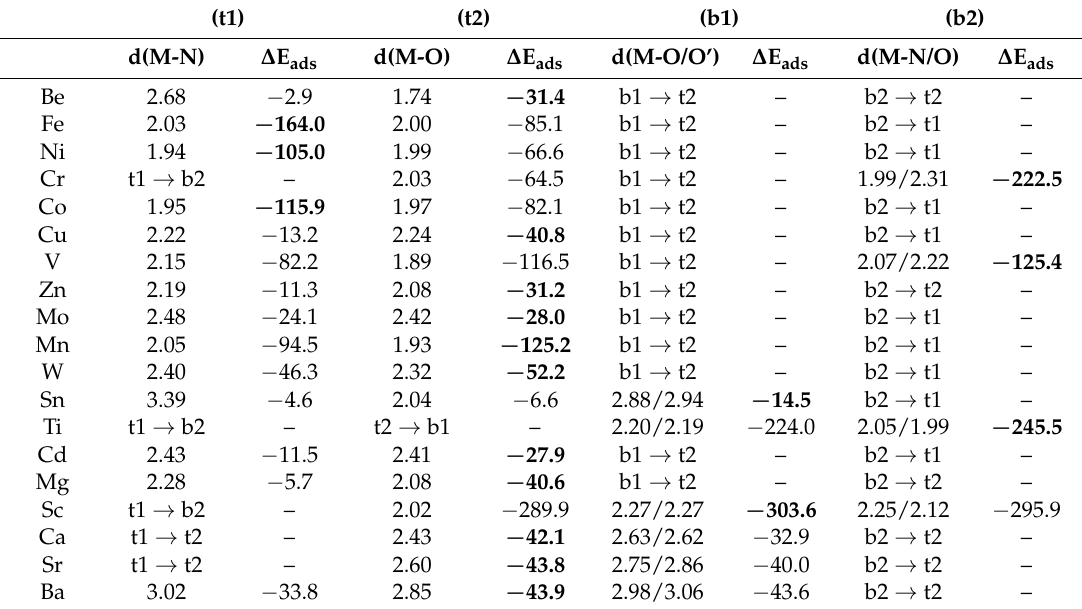
Table 2. Calculated adsorption energy ∆ E ads (kJ mol − 1 ) and metal-nitrogen/oxygen bond length d(M-N/O) (Å) between the center of the metal and nitrogen or oxygen in NO 2 for molecular adsorption of NO 2 on M-HKUST-1. The ∆ E ads values for the most stable adsorption mode are labeled in